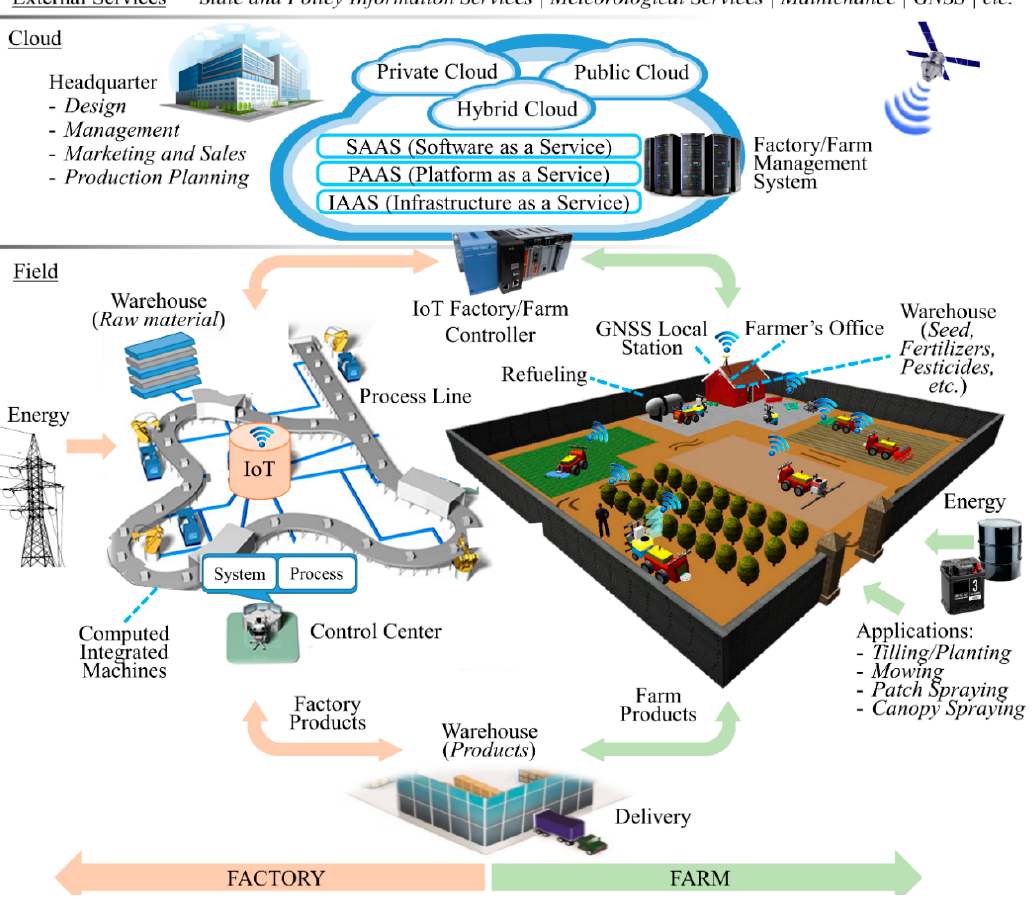
Figure 3. Smart factory (left) and smart farm (right) with their common elements (center).